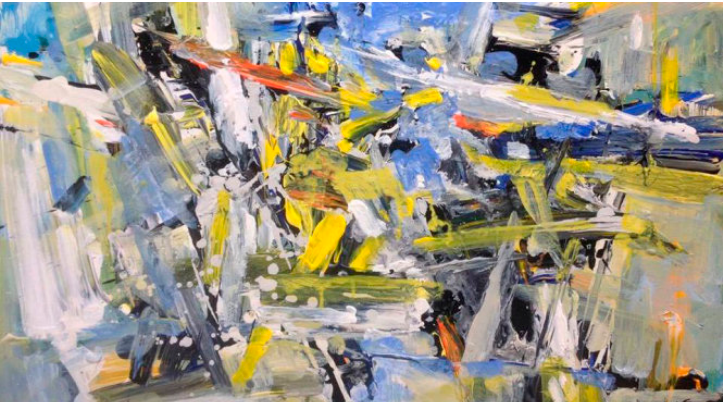
Figure A3. Nguyen Ro Hung’s copied painting with Pham An Hai’s signature 2. The image was sourced from Tuoi Tre Newspaper (Viet 2017).